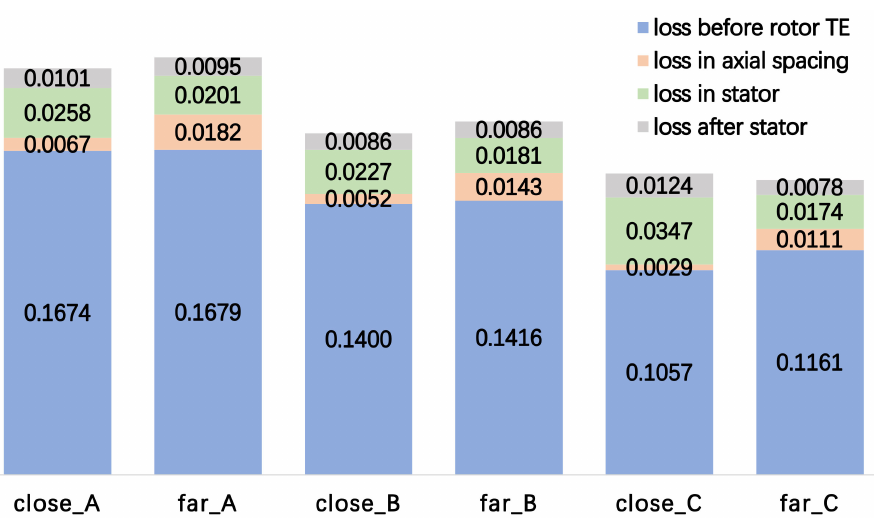
Figure 10. Time-averaged loss decomposition.